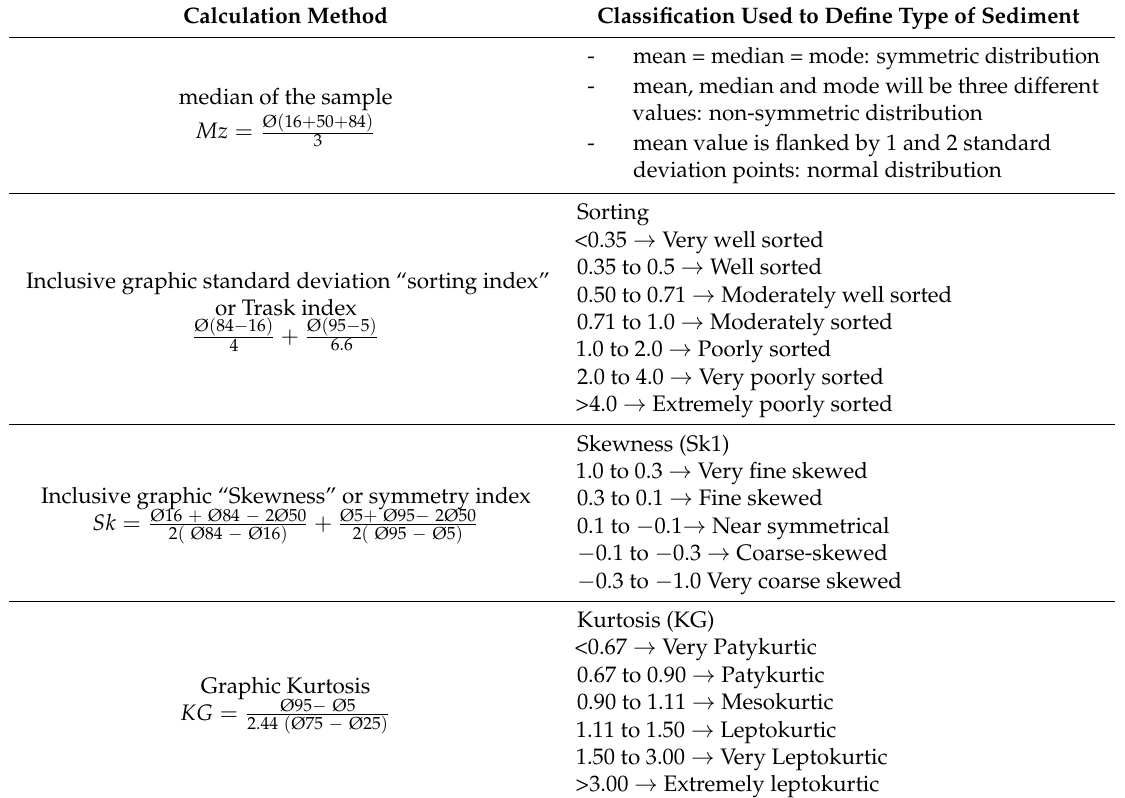
Table 2. Calculation method of grain size parameters (logarithmic graphical measures